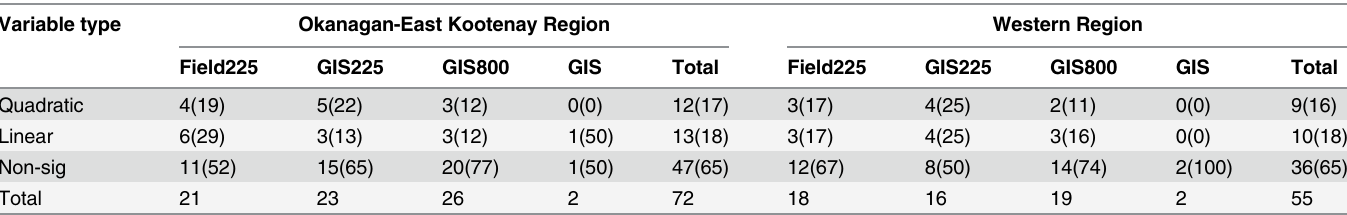
‘ Quadratic ’ indicates habitat variables were signi fi cant in a model that included a quadratic term; ‘ Linear ’ indicates habitat variables were signi fi cant as a linear term in the model; ‘ Non-sig ’ indicates habitat variable was not signi fi cant. Subheadings under each Region indicate the type of habitat variables: fi eld measurements ( ‘ Field225 ’ ), geographic information system (GIS) data from a 225 m radius around the nest or plot center ( ‘ GIS225 ’ ), and GIS data from an 800 m radius around the nest or plot center ( ‘ GIS800 ’ ). The two ‘ GIS ’ variables separated from the 225 m and 800 m scales are included in the modelling process for both scales. Numbers in brackets indicate the percent relative to the column